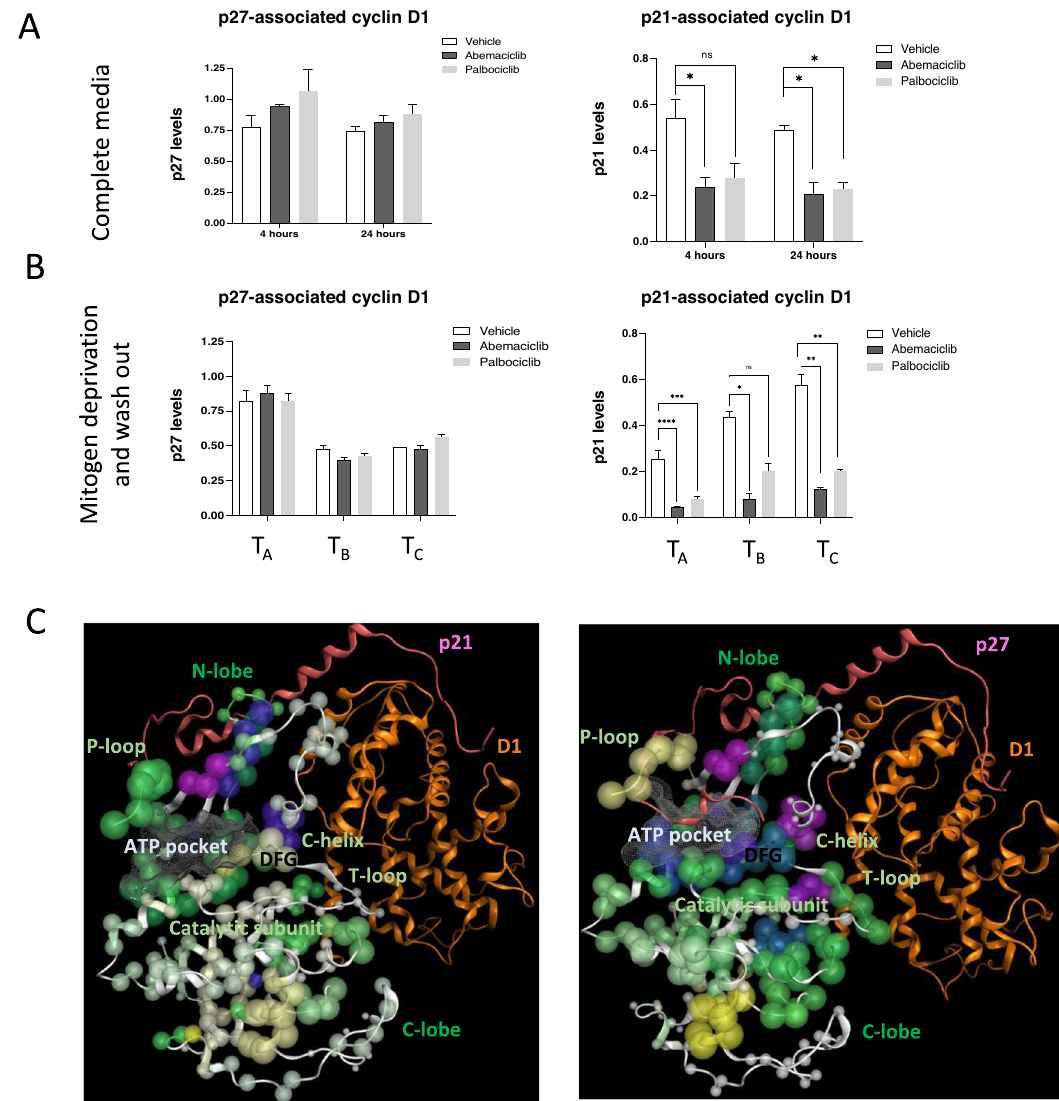
Fig. 4 CDK4/6 inhibitors selectively mediate p21 dissociation from CDK4-Cyclin D complex. T47D cells were treated with CDK4/6 inhibitor in A complete media ( n = 2) or B media lacking serum ( n = 4). Cyclin D complexes were enriched and analyzed by LC-MS/MS. Quanti fi cation of cyclin D1-associated p21 and p27 are shown. Data shown was normalized to cyclin D1 levels. B Treatment regimen was as in Fig. 3b. C p21 (left) and p27 (right) HDX log10(k) projected on their corresponding models. p21/p27 bound to CDK4-D1 active complex are modeled in both cases using the most suitable structure 1jsu.pdb (active complex of CDK2-Cyc bound to p27) as template and mapping CDK4 and cyclin D1 sequence in their corresponding proteins. * p < 0.01, ** p < 0.001, *** p < 0.0001, **** p < 0.00001, ns – not signi fi cant. P-values determined by pairwise t-test. Error bars represent ± standard